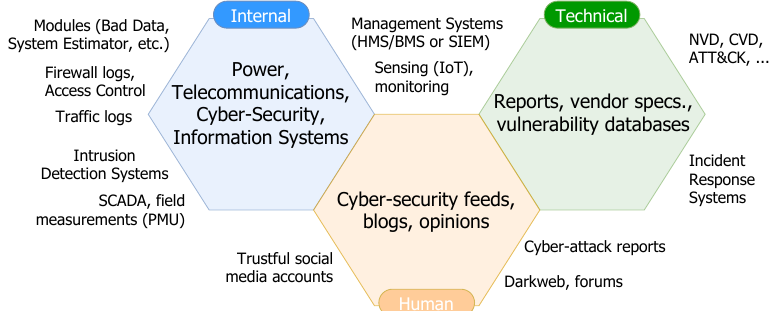
Figure 3. Common CTI sources for assessing cybersecurity concerns in non-trivial